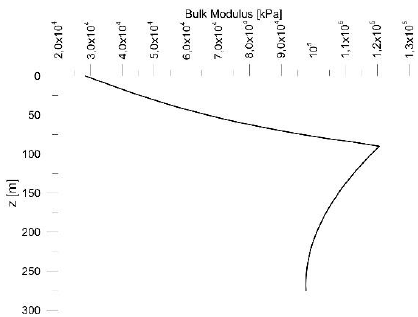
Figure 24. Bulk modulus K trend with depth.